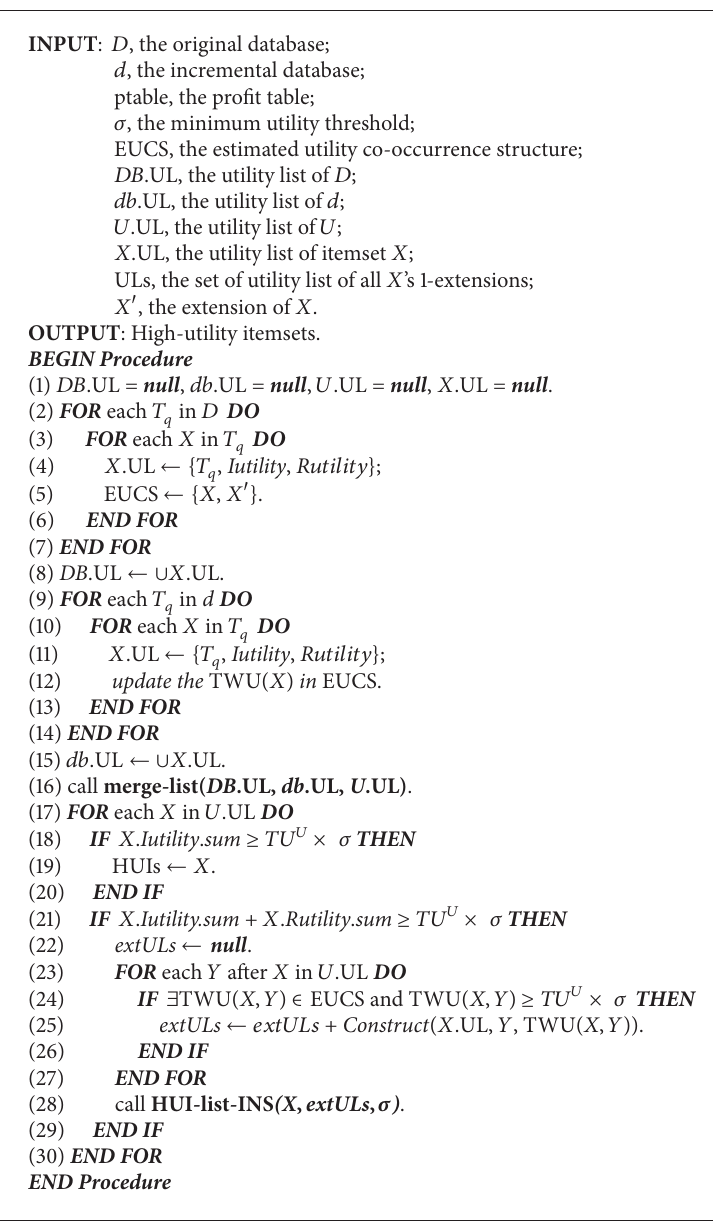
Algorithm 2: Pseudocode of the proposed HUI-list-INS